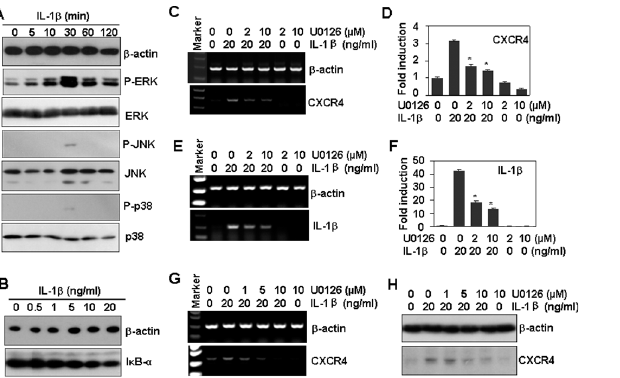
Fig 6. IL-1 β -induced ERK activation is involved in the up-regulation of CXCR4 expression. (A) The effect of IL-1 β on the activation of MAPKs. Tca8113 cells were treated with 20 ng/ml IL-1 β for the indicated time periods. The phosphorylation levels of MAPKs were measured by western blot. β -actin protein levels were measured as loading controls. (B) The effect of IL-1 β on the activation of I κ B- α . Tca8113 cells were treated as described in (A). I κ B- α protein levels were measured by western blot. β -actin protein levels were measured as loading controls. (C) The effect of ERK inhibition on IL-1 β -induced CXCR4